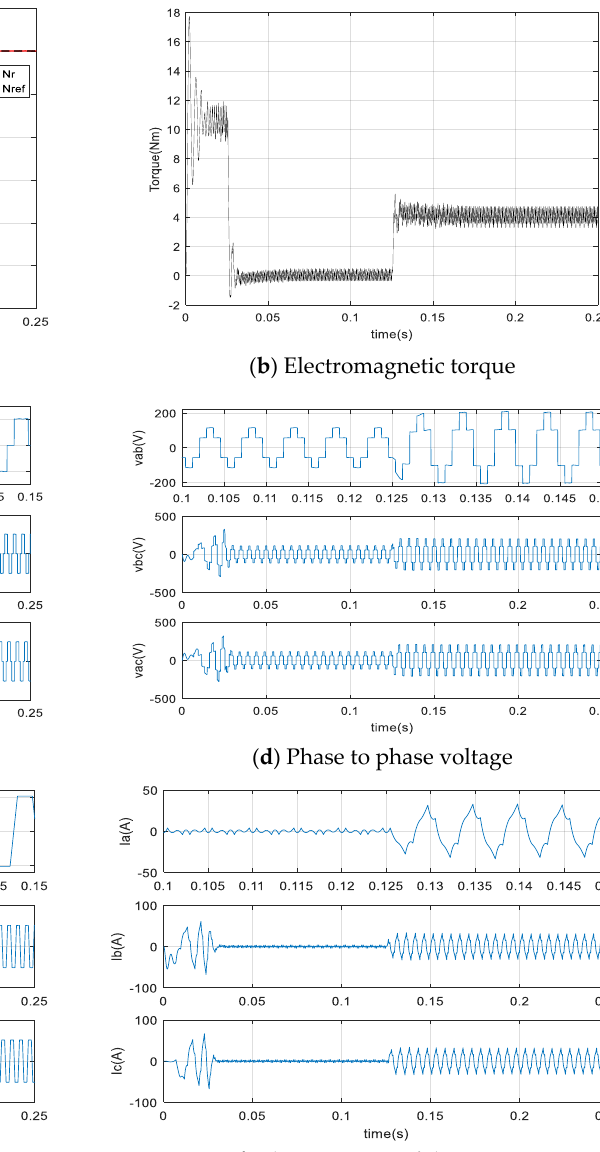
Figure 16. Results of simulation by using FFA_PI controller.